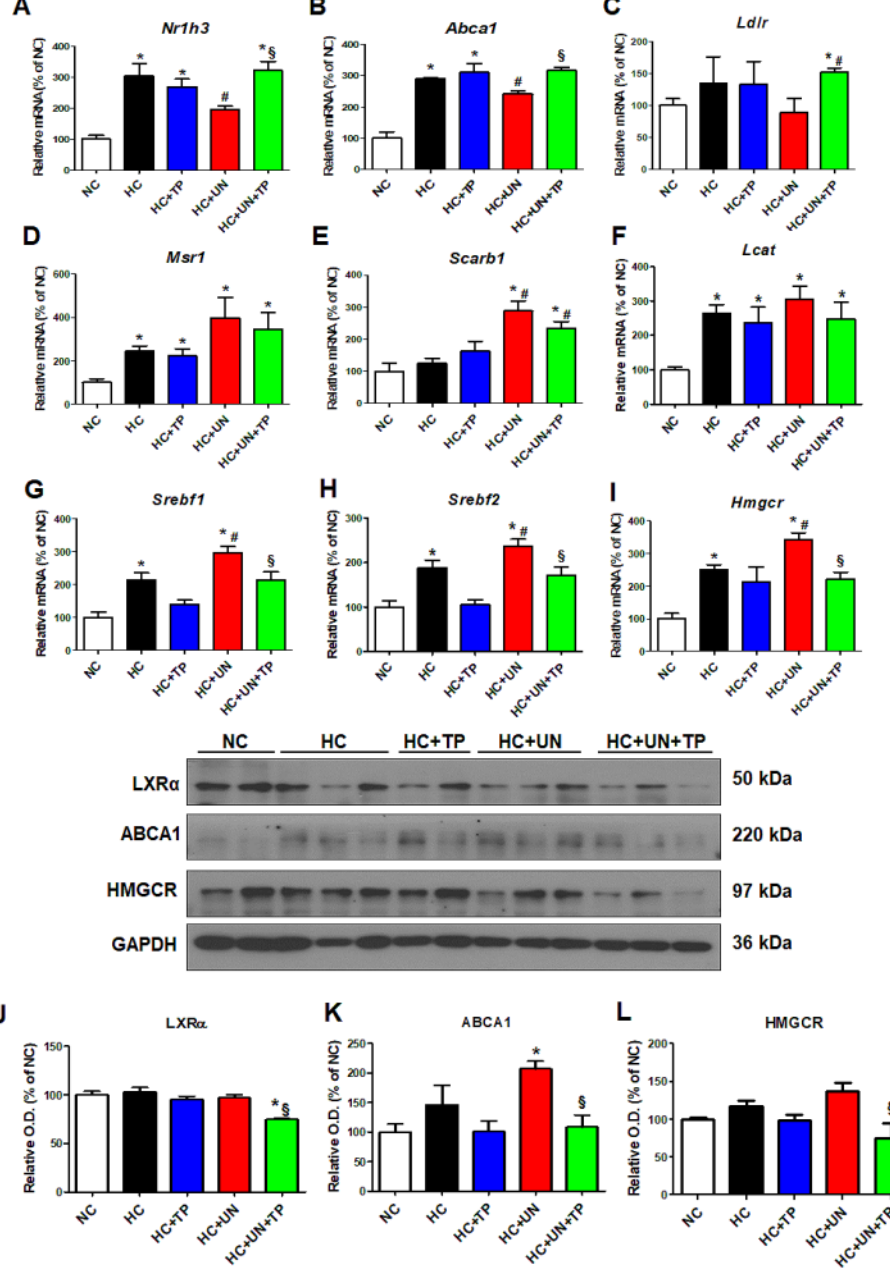
Figure 2. TP decreased cholesterol accumulation in the kidney through regulation of genes involved in cholesterol transport and synthesis. Real-time RT-PCR was performed to determine the expression levels of genes involved in cholesterol efflux ( A , B ), LDL receptor ( C ), modified LDL influx transport ( D , E ), cholesterol esterase ( F ), triglyceride synthesis ( G ), and cholesterol synthesis ( H , I ). ( J – L ) Representative western blot for LXR α , ABCA1, HMGCR, and GAPDH. Relative protein expression was determined using densitometry. Differences among the groups were analyzed by one-way non- parametric ANOVA, followed by Tukey’s multiple comparison test. Data represent mean and SEM.